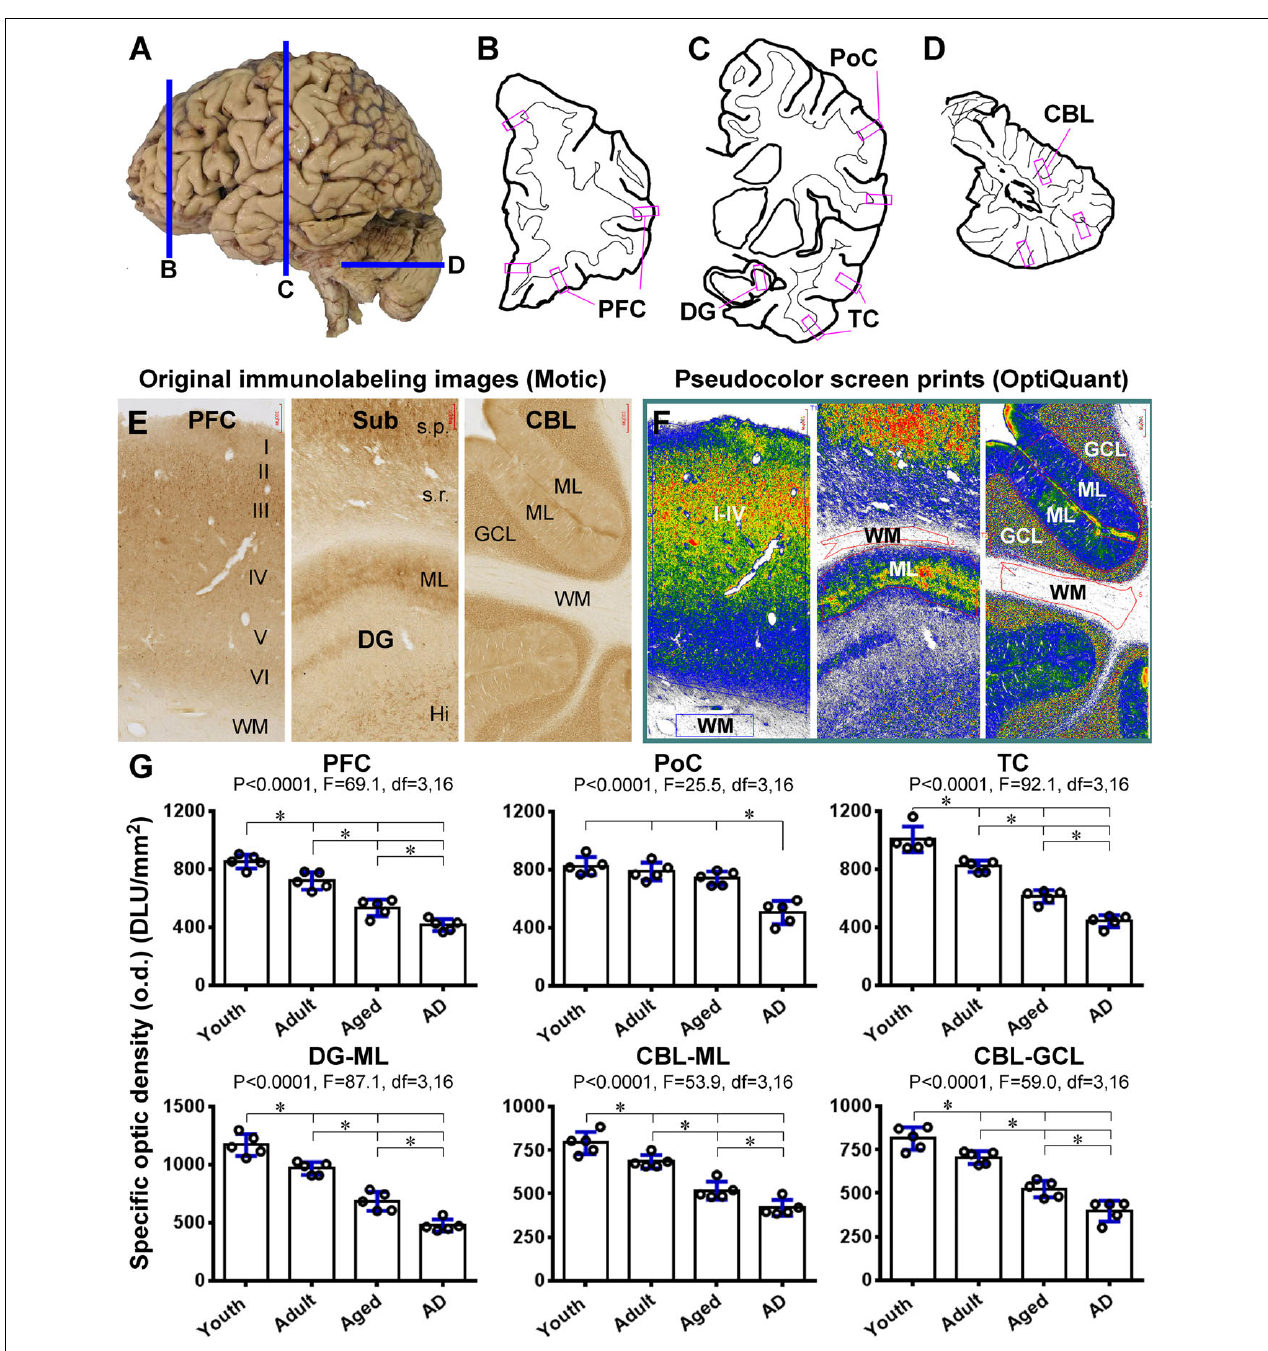
FIGURE 13 | Densitometric analysis of age- and AD-related decrease in Shank3 IR in representative human brain subregions. (A–D) show the sampling of brain sections relative to the lateral view of the human brain, with the shapes of a frontal slice passing the prefrontal cortex (B) , a frontal slice passing postcentral gyrus and mid-hippocampus (C) and a horizontal slice passing the mid-cerebellum (D) , drawn schematically. The framed areas marked in purple represent the approximate locations of the “areas of interest” for the measurement of optic densities (o.d.) of Shank3 IR in the sections within the above thick brain slices. Panel (E) shows the original images extracted at 4 × magnification from gyral portions of the prefrontal neocortex, the hippocampal formation covering the middle segment of the dentate gyrus and cortex of the posterior cerebellar lobe, using the Motic-scanned whole region images. Panel (F) is corresponding pseudocolor screen prints of OptiQuant working interfaces, wherein measuring templates are illustrated. Thus, the o.d. (expressed as DLU/mm 2 ) obtained from the gray matter regions (i.e., layers I–VI, ML, GCL) is defined as the total density of the IR, while the o.d. measured in the nearby white matter (WM) area is considered as the background (the cutoff level). The specific o.d. is calculated by subtracting the background from the total o.d. in the corresponding areas of interest. Panel (G) pots the means of specific o.d. of Shank3 IR obtained from the indicated neocortical areas (layers I–VI), the molecular layer (ML) of the dentate gyrus (DG), and the ML and GCL of the cerebellar cortex in individual brains in youth, adult, aged, and AD groups. Statistics (one-way ANOVA with Bonferroni’s post hoc test) are as indicated. Additional abbreviations are as defined in Figure 3 . * indicating significant difference of the means of individual pairing groups according to Bonferroni’s multiple comparison post hoc